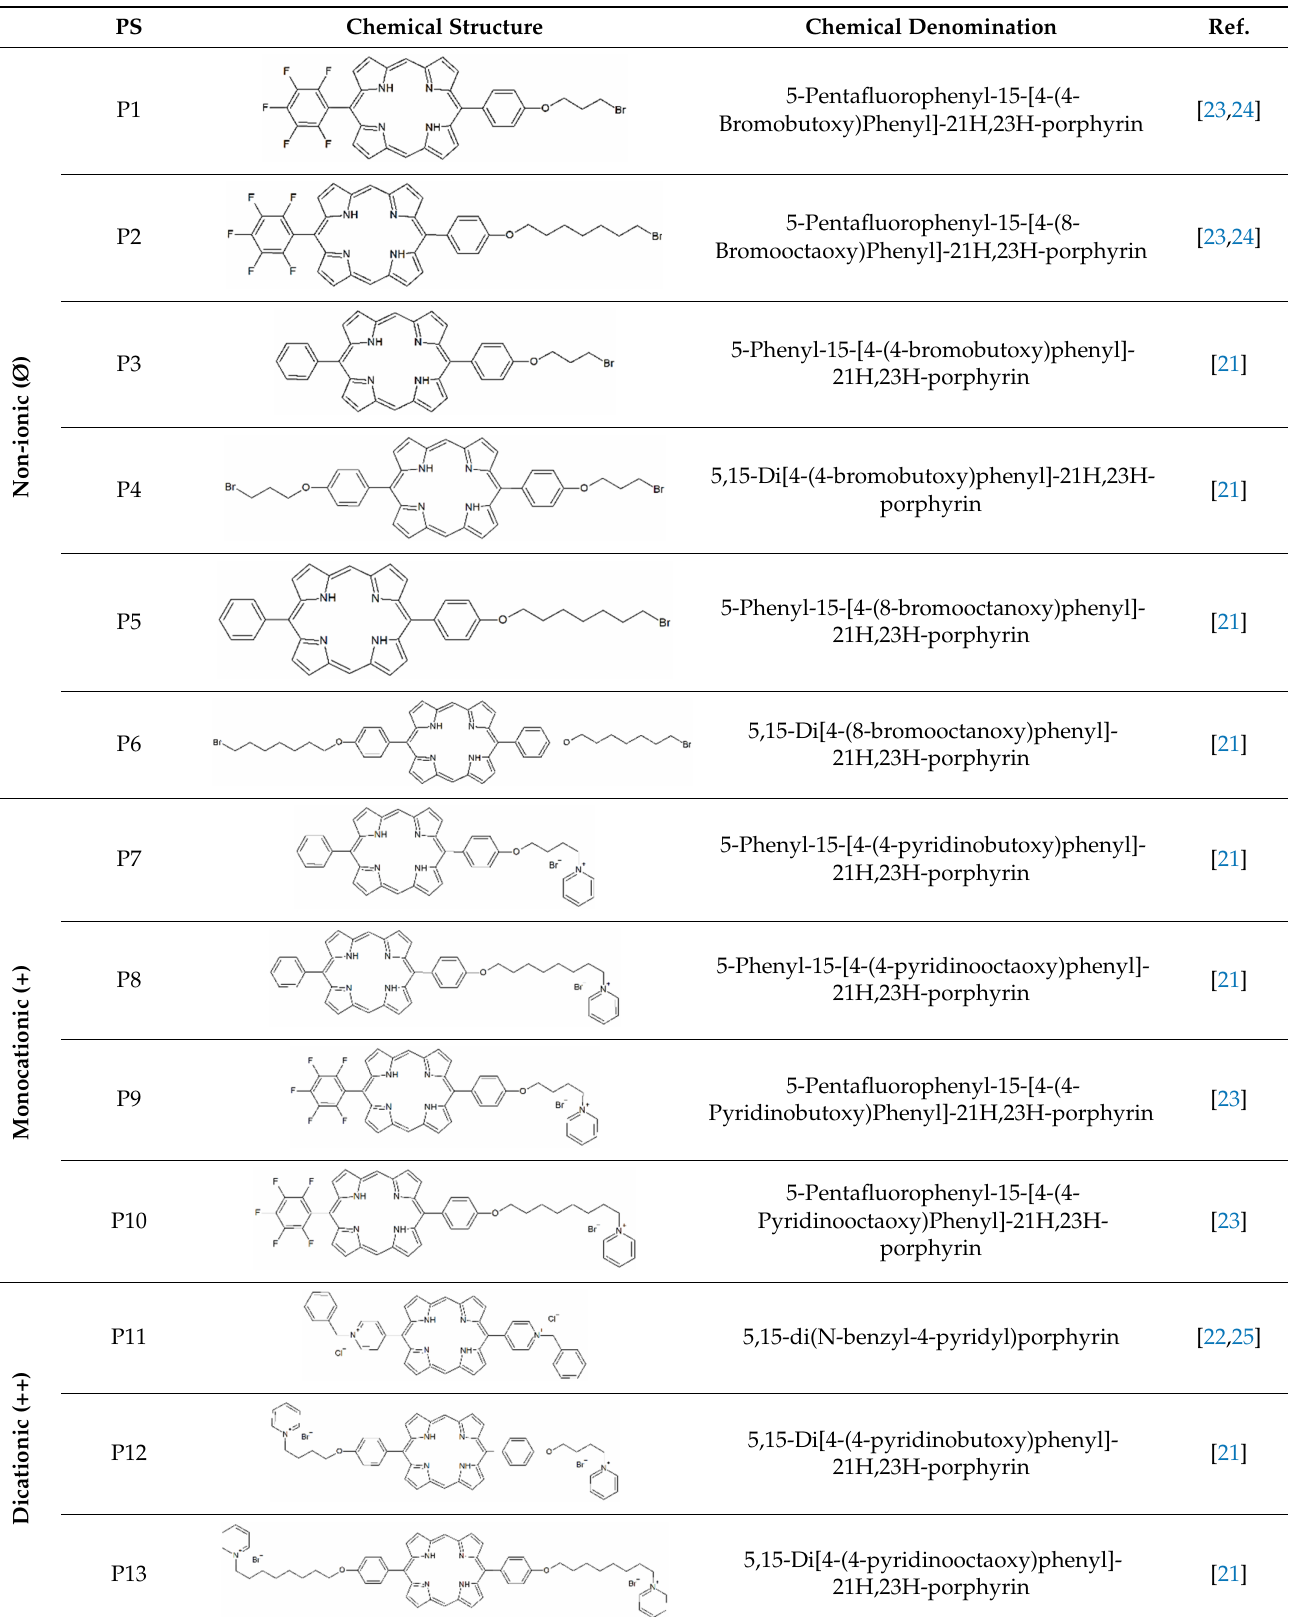
Table 1. List of diaryl-porphyrins ( P1 – P13 ) used in this